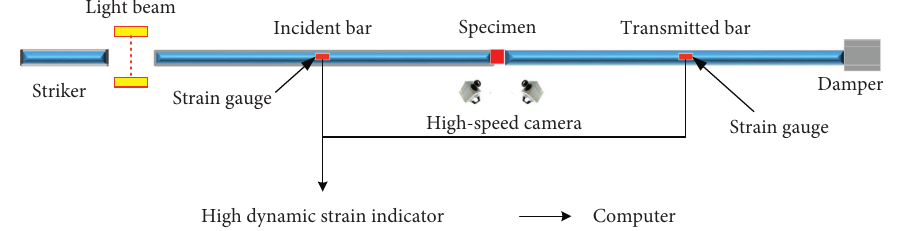
Figure 2: The SHPB test system. Table 2: ∗ MAT_JOHNSON_COOK [22] constants for